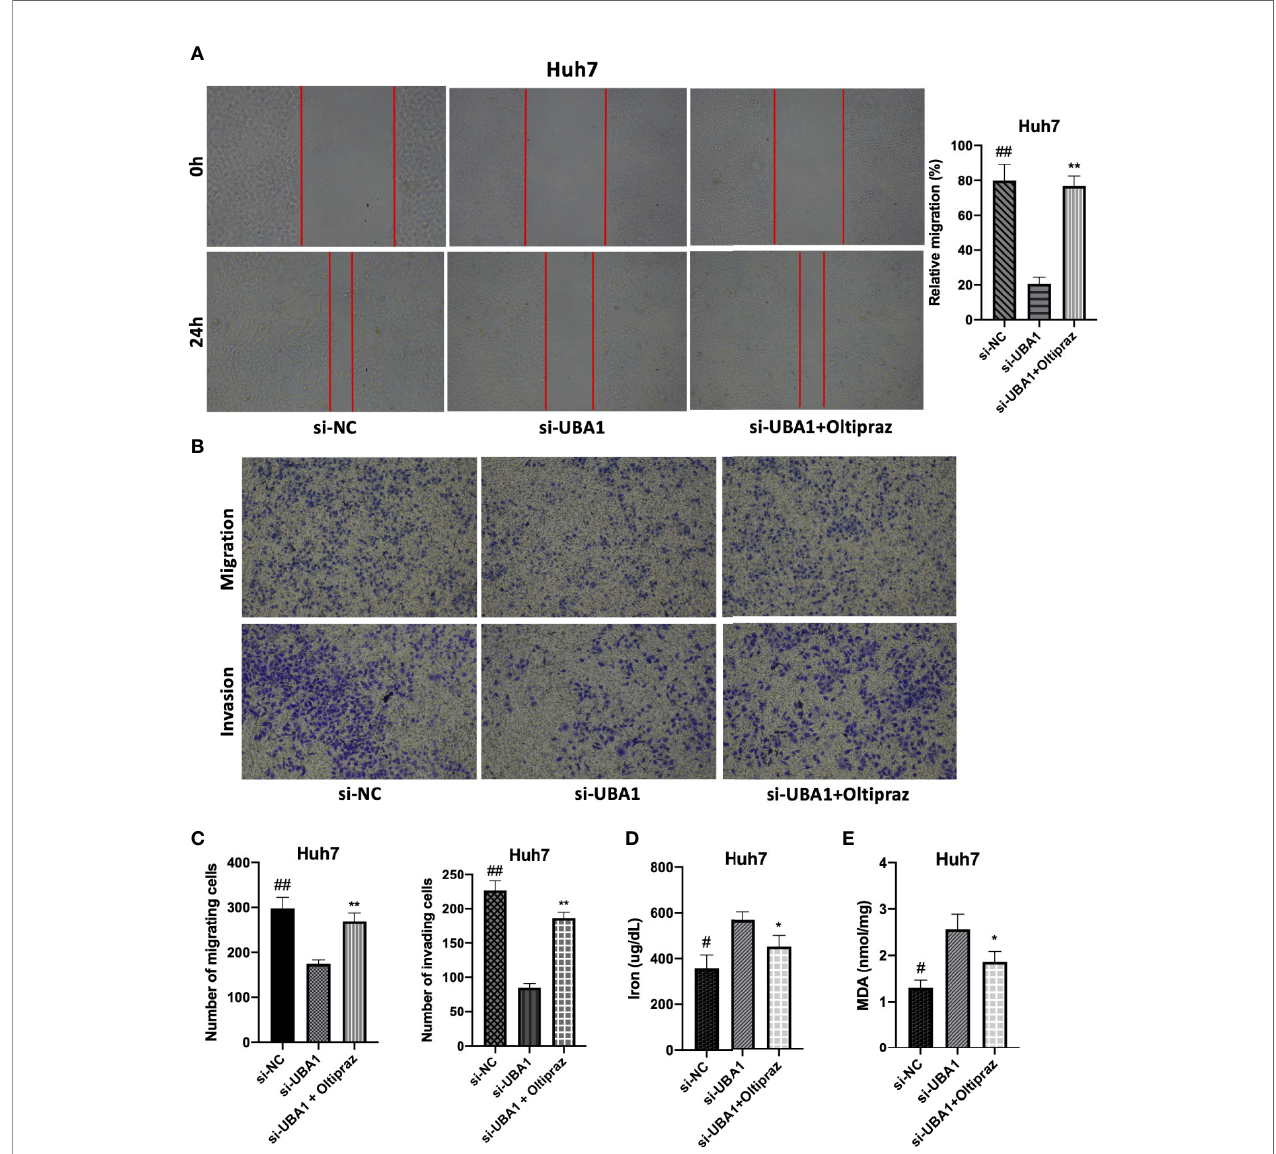
FIGURE 8 | Effects of changed UBA1 expression on malignant phenotypes and ferroptosis in HCC cells. (A) Wound healing assay. Migratory cells to the wound were determined following different treatments and imaged. (B, C) Transwell migration and invasion assays. Huh7 cells treated with different drug doses were analyzed for their invasion and migration capacities. (D) Ferrous iron and the MDA content (E) in Huh7 cells subjected to si- UBA1 transfection (* si- UBA1 versus si- UBA1 +oltipraz, ** p < 0.01, * p < 0.05; # si-NC versus si- UBA1 , ## p < 0.01, # p <